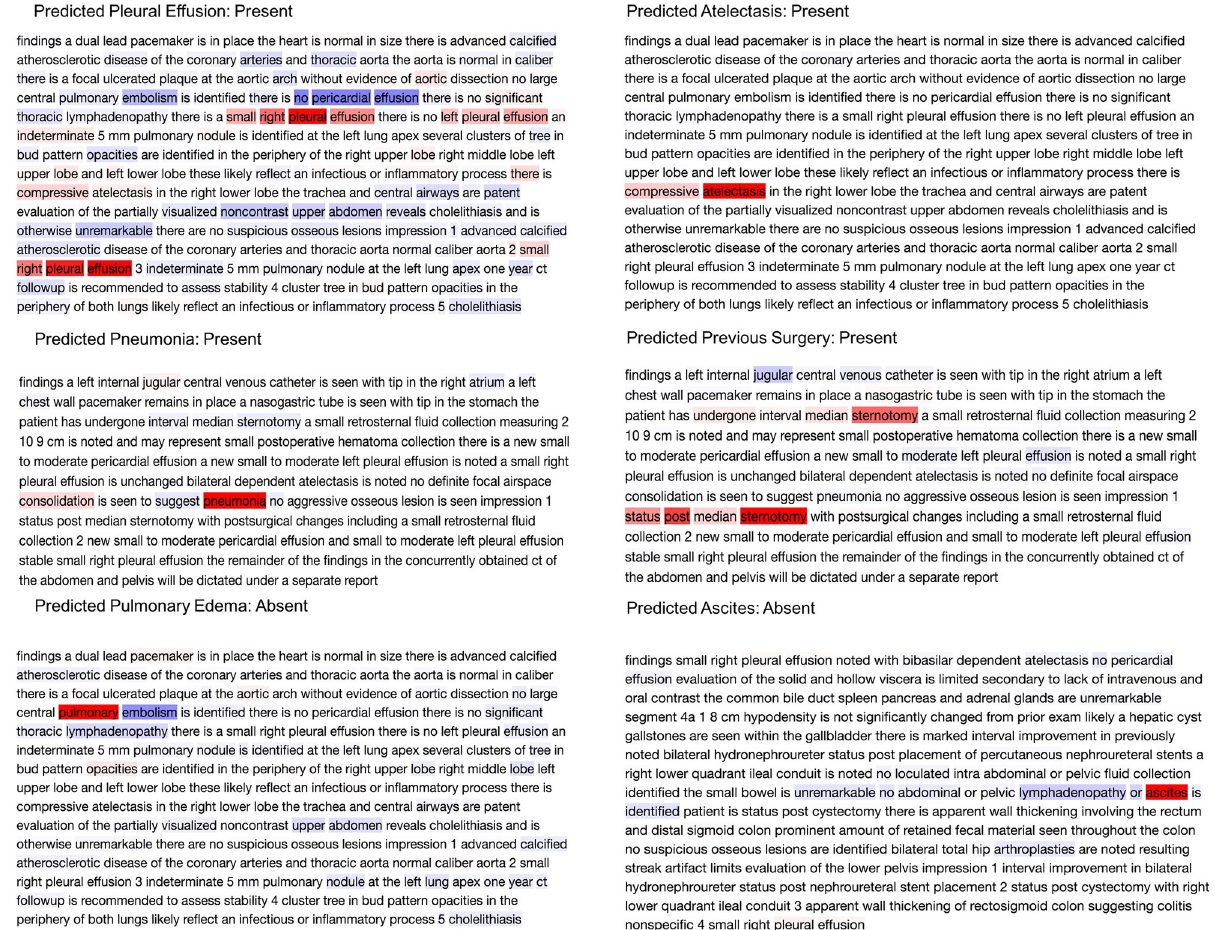
Fig 3. Explaining the output of a trained CNN model using layer-wise relevance propagation. The predicted label is considered as the true class label. The color intensities are normalized to the absolute value of maximum relevance score per report such that the deepest red denotes the word with the highest positive relevance in the class label prediction, while the deepest blue denotes the most negative relevance score in the prediction of the same label.